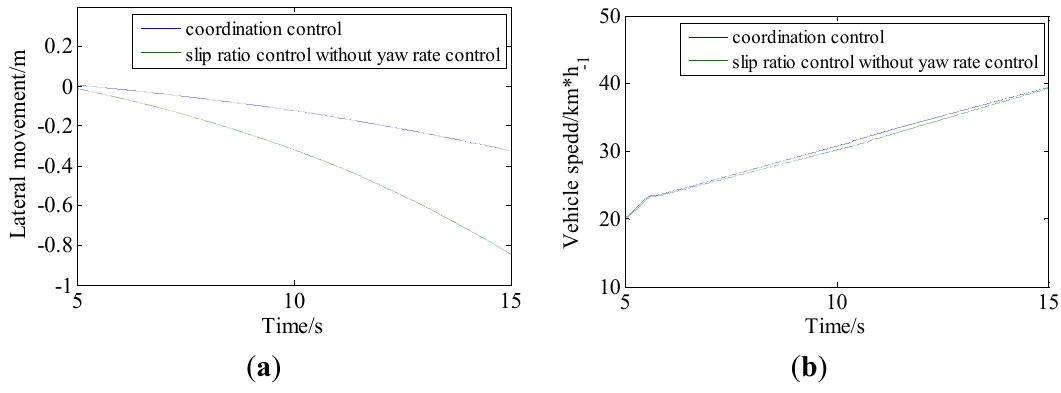
Figure 20. Experiment results of acceleration slip regulation on variation split- μ road: ( a ) slip ratios of driving wheels; ( b ) yaw rate of vehicle; ( c ) torque commands of slip ratio control and yaw rate control; and ( d ) motor torque outputs.